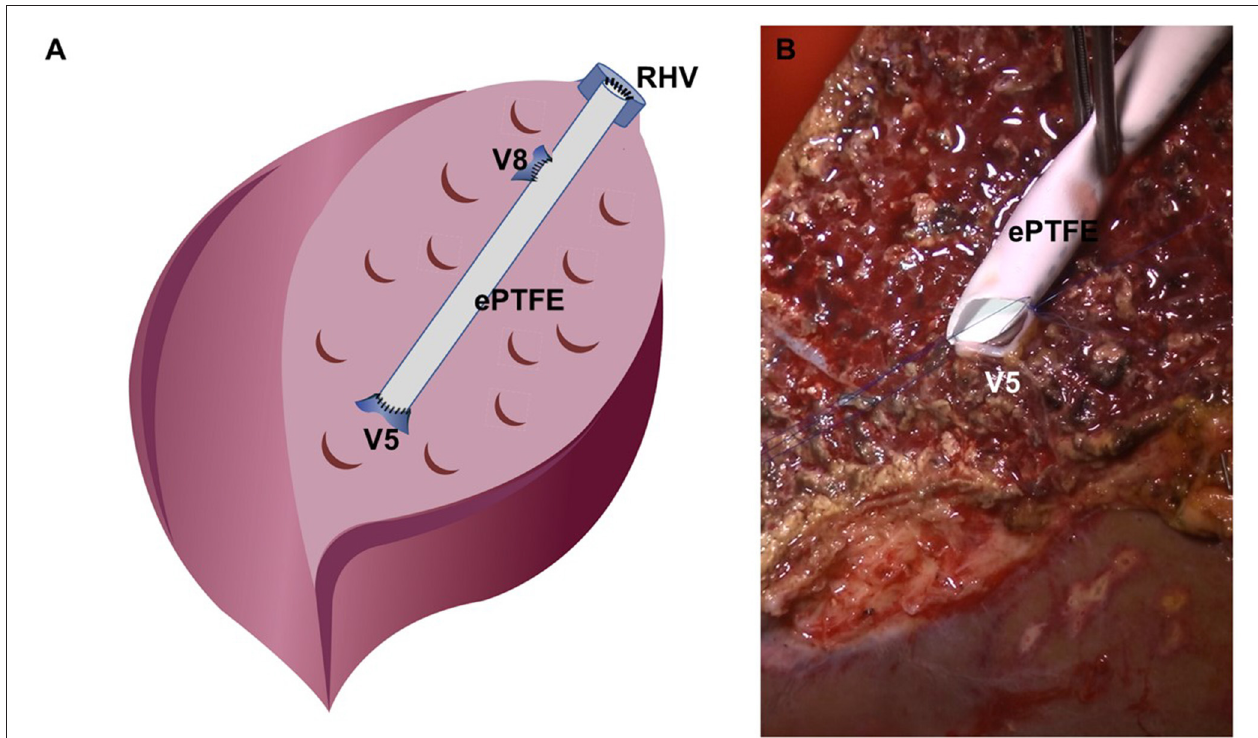
FIGURE 2 | Reconstruction for the middle hepatic vein branch at the bench. (A) Schematic figure of bench work, (B) surgical field image of V5 darinage using the ePTFE graft.